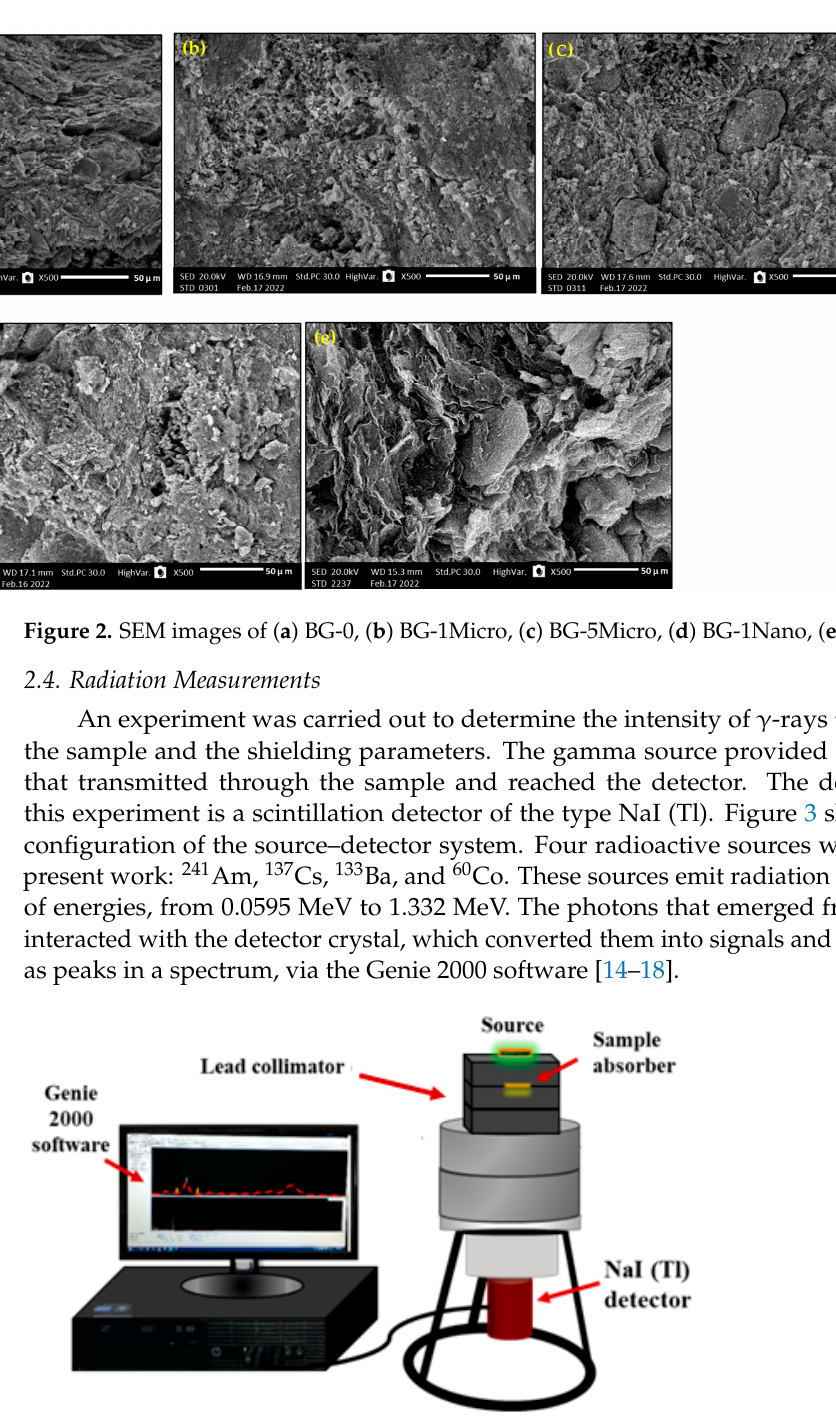
Figure 3. The experimental setup configuration of the sample with respect to the radioactive source and the detector.